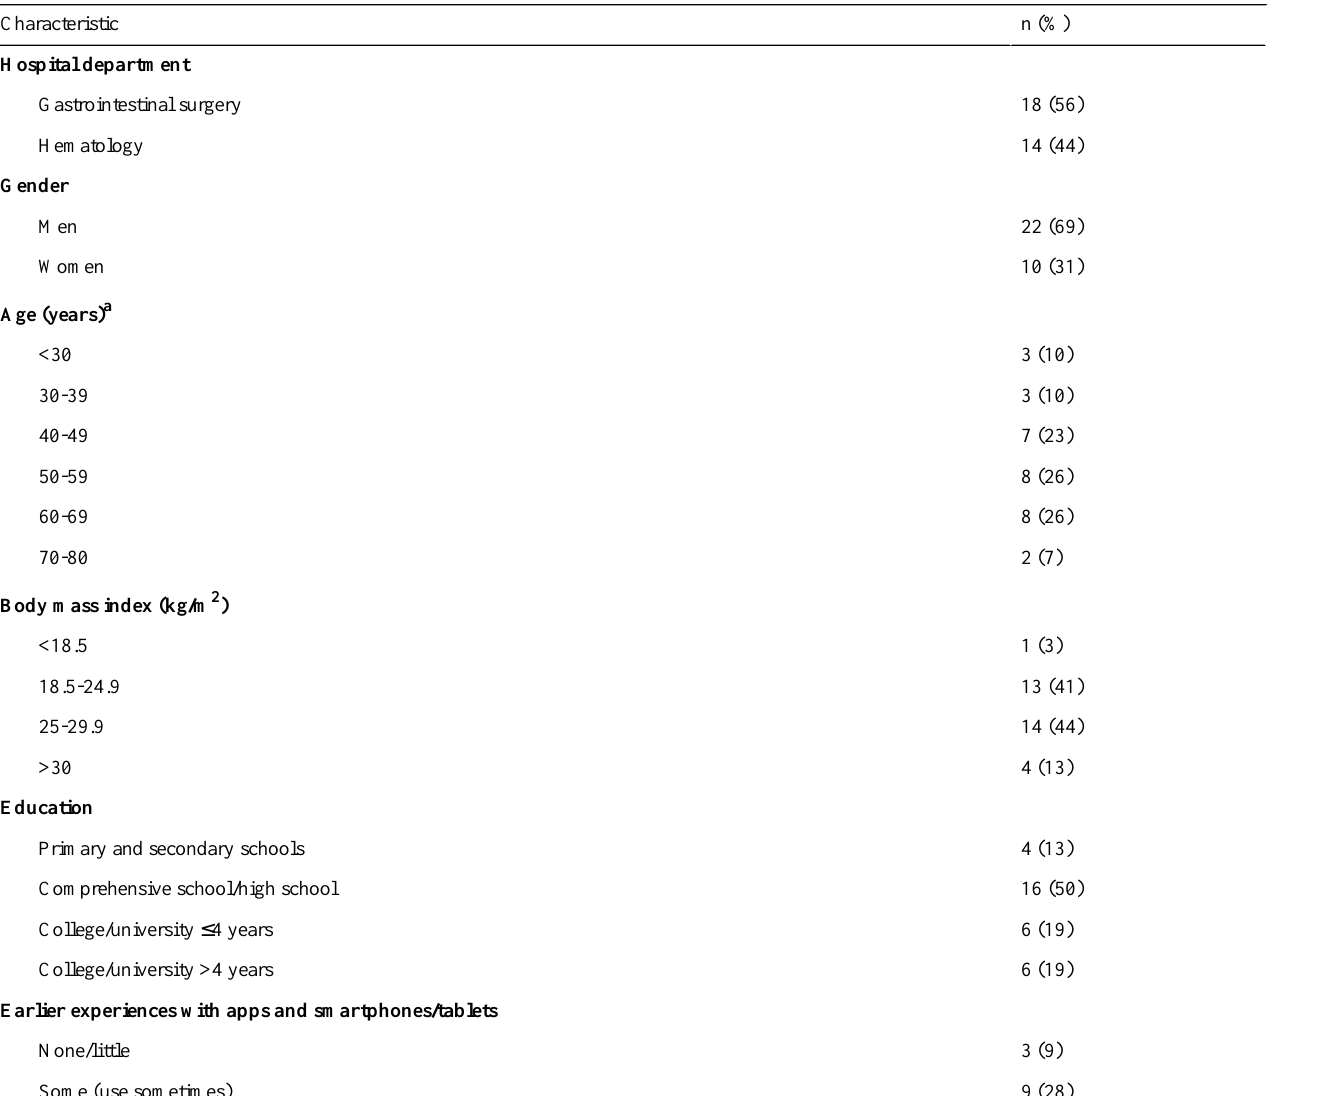
Table 1. Characteristics of participants (n=32) in the evaluation study of